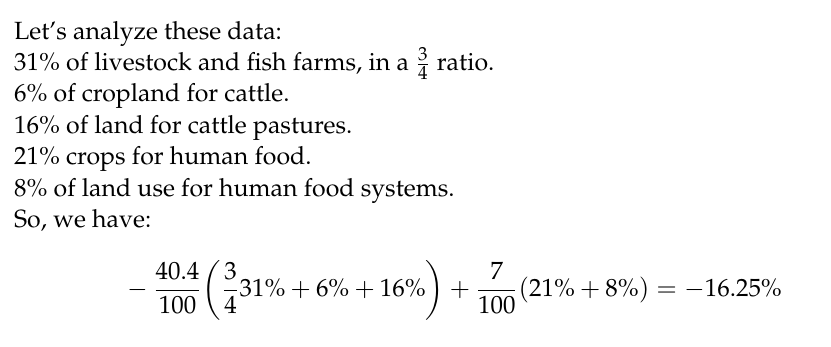
Figure 11. Global greenhouse emissions from food production. Adapted from Ref.